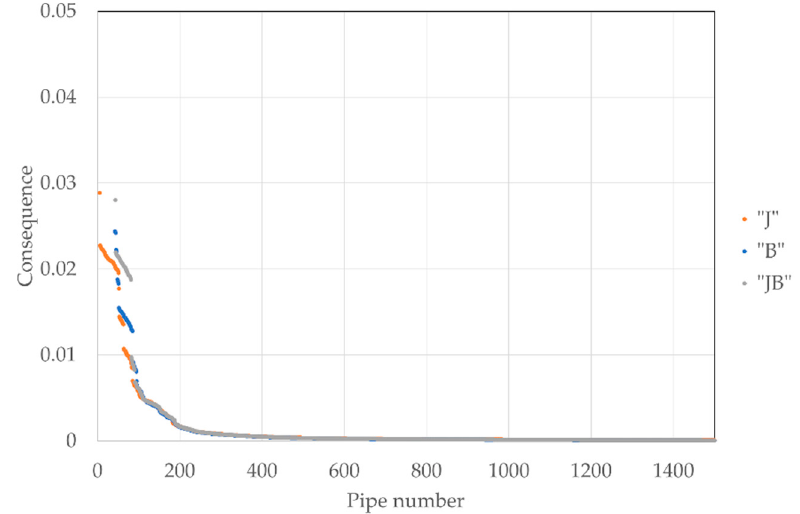
Figure A7. Plot of consequence values sorted from highest to lowest values.